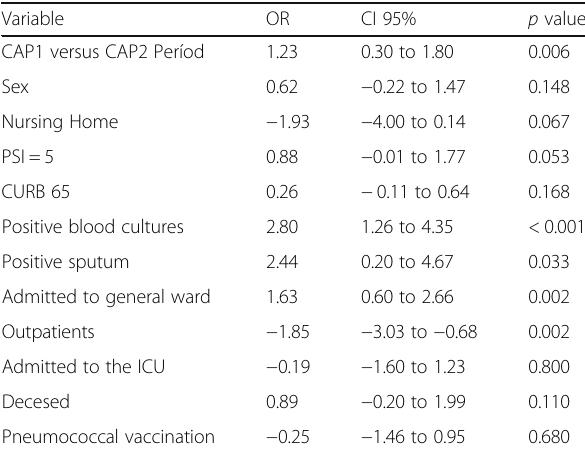
Table 3 Conditional Logistic Regression model for matched cases and controls, Univariate Analysis, The odds ratio (OR), the 95% confidence index (CI 95%) and the p value are displayed Variable